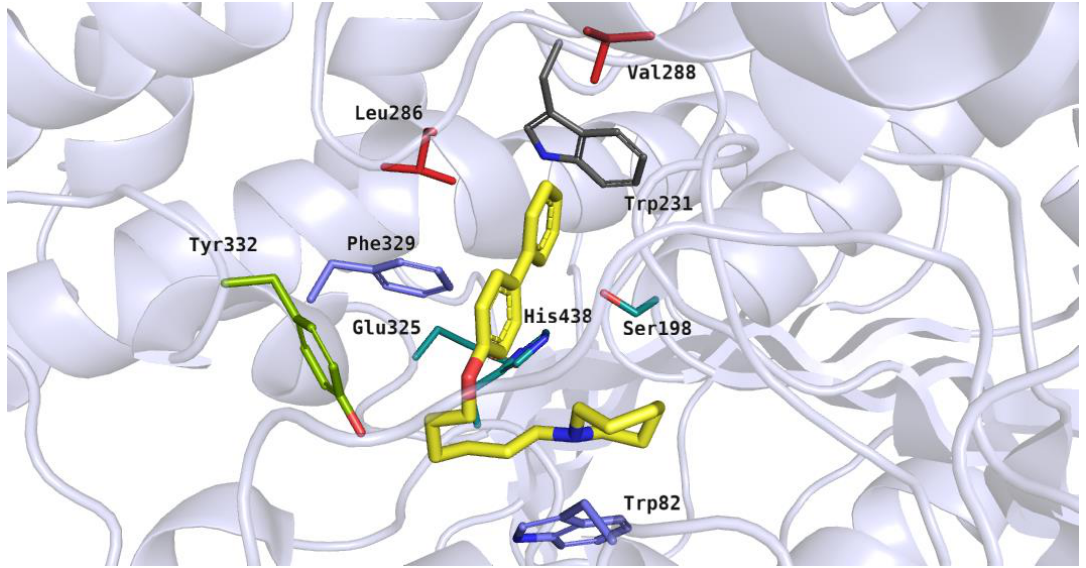
Figure 10. Binding mode of compound 5 within the butyrylcholinesterase active site. Residues colored in teal represent the catalytic triad, blue — anionic site, green — peripheral anionic site, red — acyl pocket.